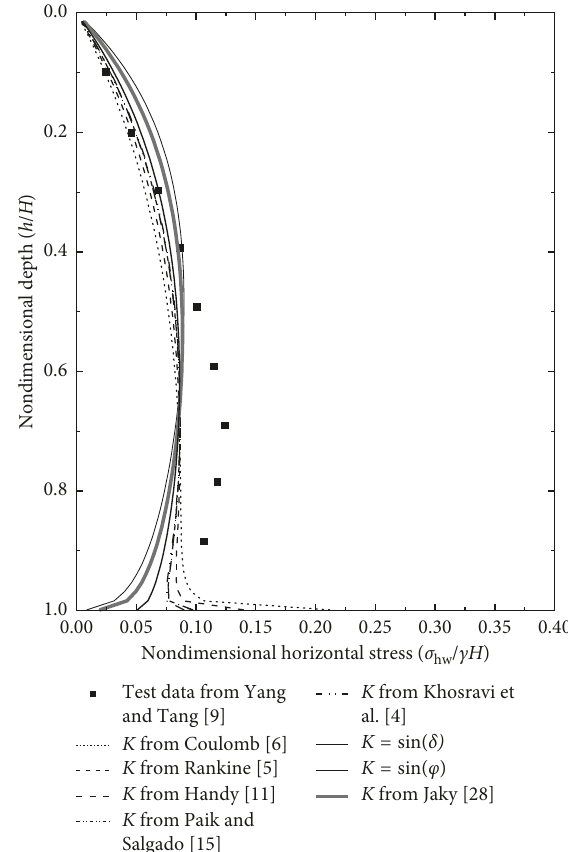
Figure 7: Measured and calculated dimensionless earth pressure versus h / H , for width �